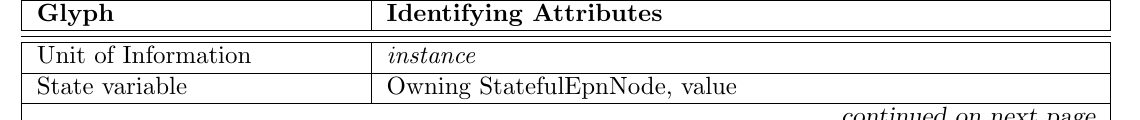
Table 3.1: The Identifying attributes of Process Description node glyphs. When a glyph is always unique in a map, this is indicated by the term instance . The term state values indicates that the values of all the EPN’s state variables are used in the definition of its